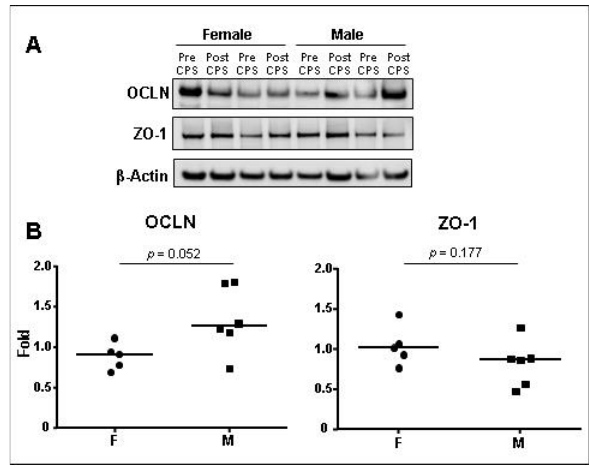
Figure 7. Protein expression levels OCLN and ZO-1 in jejunal mucosa after CPS. ( A ) Representative Western blot image showing expression of OCLN and ZO-1 in the jejunal mucosa of two representative females and two representative males before and after cold pain stress (CPS). Normalization was performed using β -actin as loading control. ( B ) Bands were quantified, and results are expressed as fold–change, each dot represents the fold change of each individual (five females and six males) before (Pre) and after CPS (Post). Intergroup comparisons were performed using the Mann–Whitney U test. p values are indicated. F: females; M: males; OCLN: occludin, ZO-1: zonula occludens